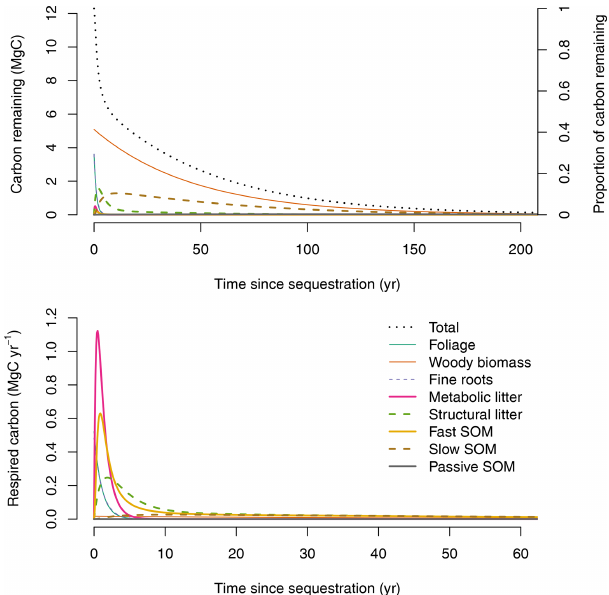
Figure 3. Fate of carbon ( M s (t) , left axis; and M s1 (t) , right axis) entering the ecosystem according to the TECO model parameter- ized for the Duke Forest and calculated using Eq. (13) for the upper panel, and respired carbon ( r(t) ) returning back to the atmosphere calculated using Eq.